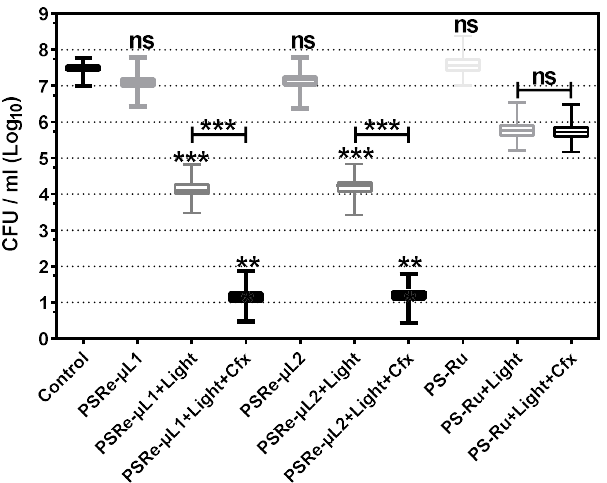
Figure 5. Antimicrobial photodynamic inactivation of clinical isolates of K. pneumoniae . ( A ) Growth inhibition of 118 clinical isolates of K. pneumoniae subjected to antimicrobial photodynamic inacti- vation (aPDI) with PSRe-µL1 and PSRe-µL2 compounds compared to control, PS-Ru. The bacteria were utilized at 1 × 10 7 CFU/mL and mixed in triplicate with 4 µg/mL of PSRe-µL1 and PSRe-µL2 compounds. For the aPDI, the mixture of bacteria with the PSs was exposed for 1 h at 17 µW/cm 2 of white light. As a control, bacteria combined with the PSs not exposed to light and bacteria not com- bined with the control PS-Ru were included. Colony count enumerated of viable bacteria on ca-MH agar after serial micro-dilution. The CFUs/mL values are presented as means ± SD on a log 10 scale. Not significant (ns) p > 0.05 by Student’s t -test among treated bacteria compared to control; ** p < 0.01, *** p < 0.001 by Student’s t -test among treated bacteria compared to control.